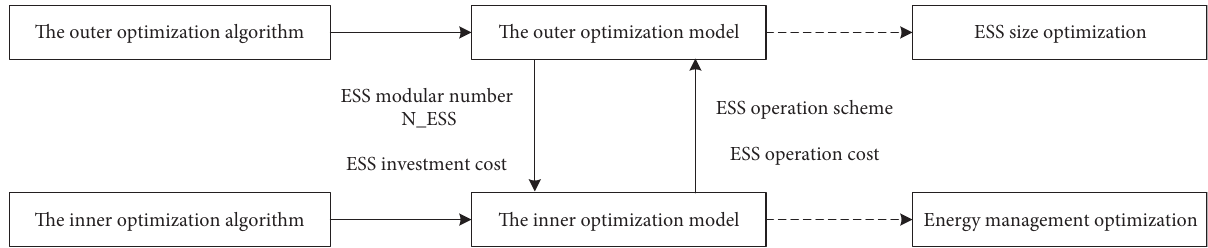
Figure 2: Bi-level configuration of traditional ESS optimal size problem with considering energy management.